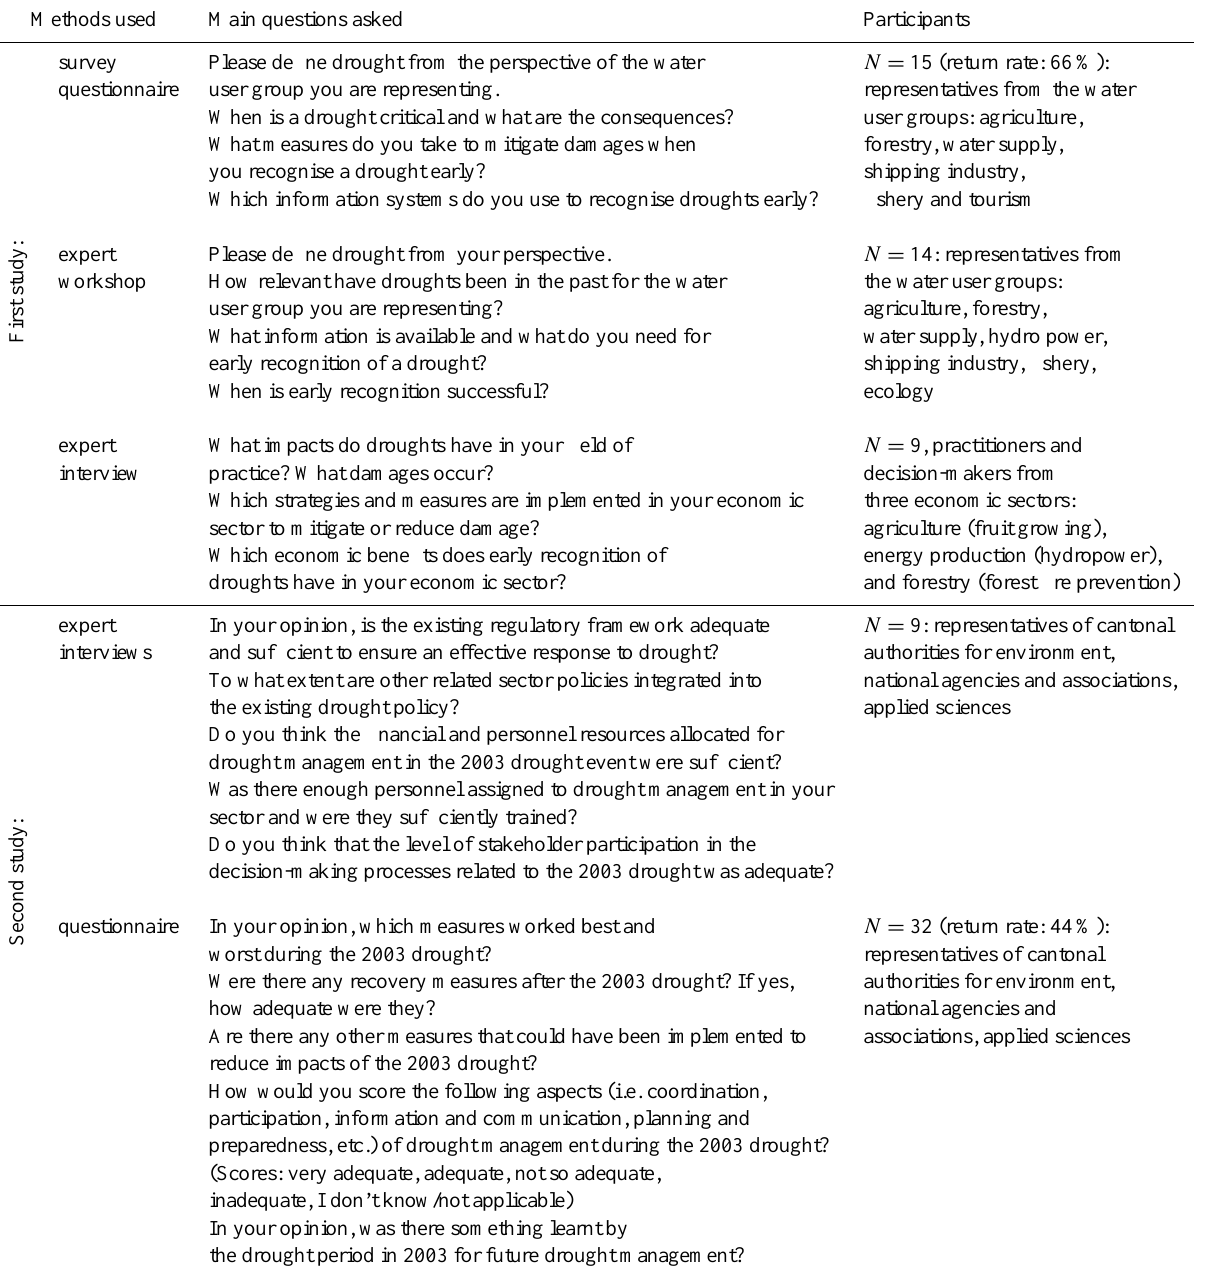
Table 2. Overview over the methods used, including main questions asked in interviews, workshop and surveys. Methods